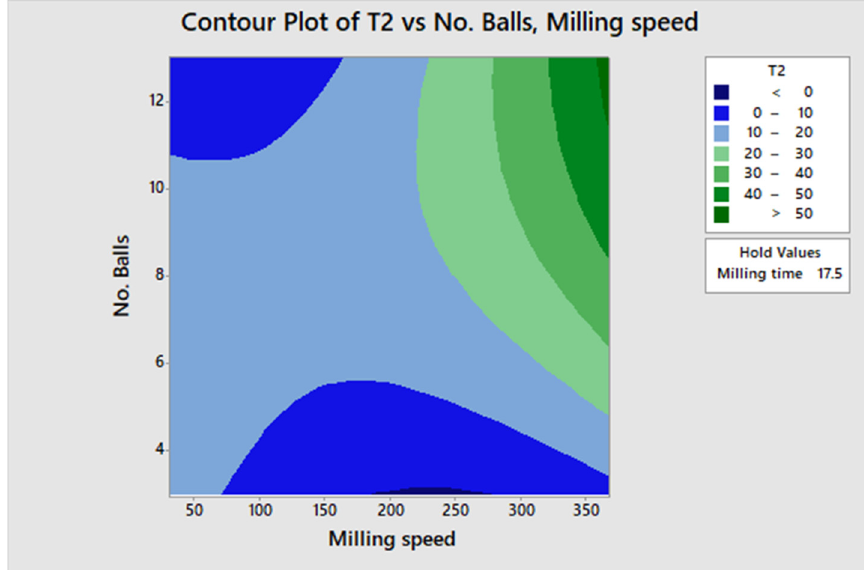
Figure 11. T2 vs. no. of balls– milling speed.